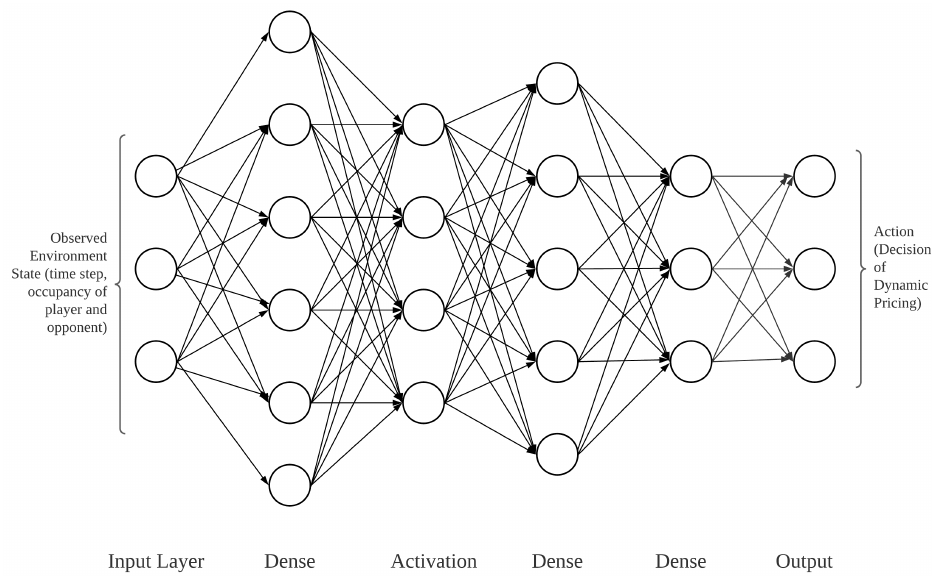
Figure 9. Architecture of the proposed neural network model.